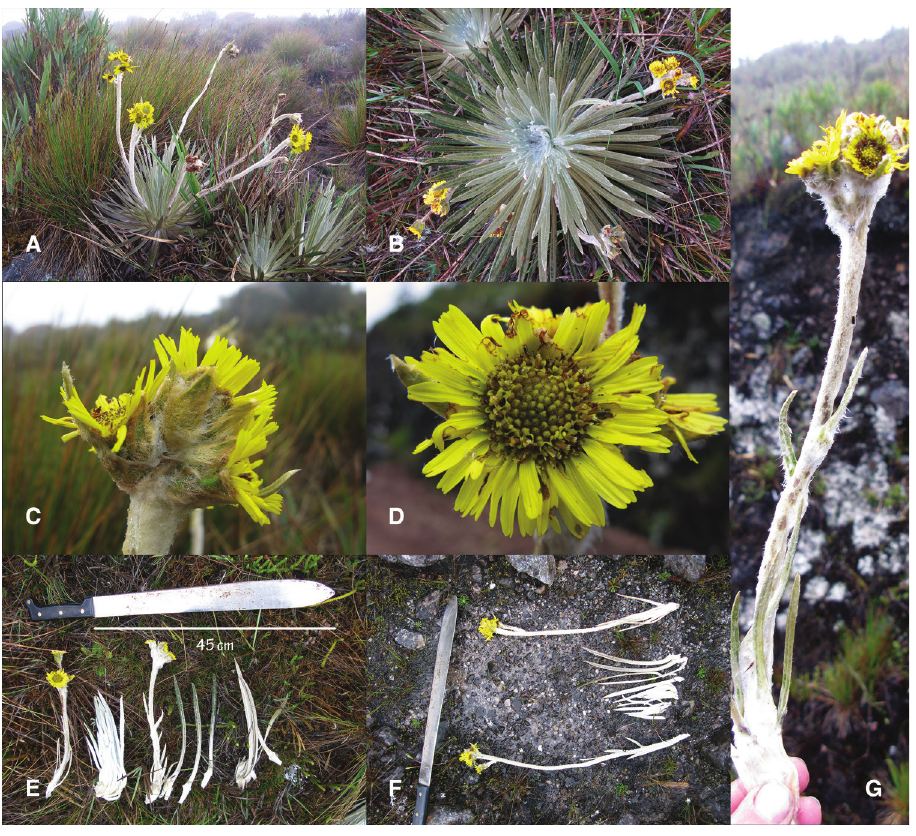
Figure 1. Espeletiopsis diazii : A acaulescent (sessile) habit B whitish rosette from top C lateral view of capitulescence showing a dense glomerate cyme of capitula D capitulum of the holotype collection ( M. Diazgranados & L.R. Sánchez 3898 ) e paratype collection ( M. Diazgranados & L.R. Sánchez 3897 ) F holotype collection ( M. Diazgranados & L.R. Sánchez 3898 ) G capitulescence showing the alternate bracts along the